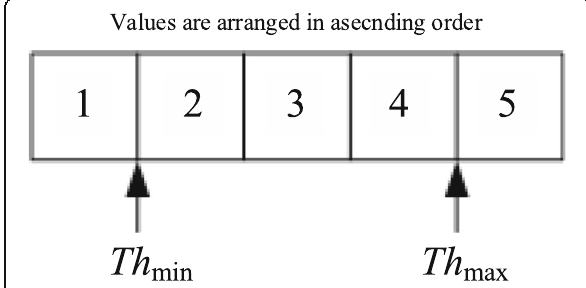
Fig. 4 Determination of KQI